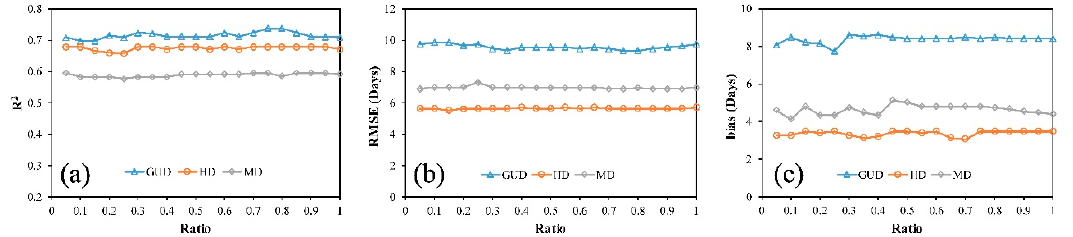
Figure 13. The values of ( a ) the coefficient of determination (R 2 ), ( b ) root mean square error (RMSE), and ( c ) bias obtained for average phenological curves produced using different sample sizes.